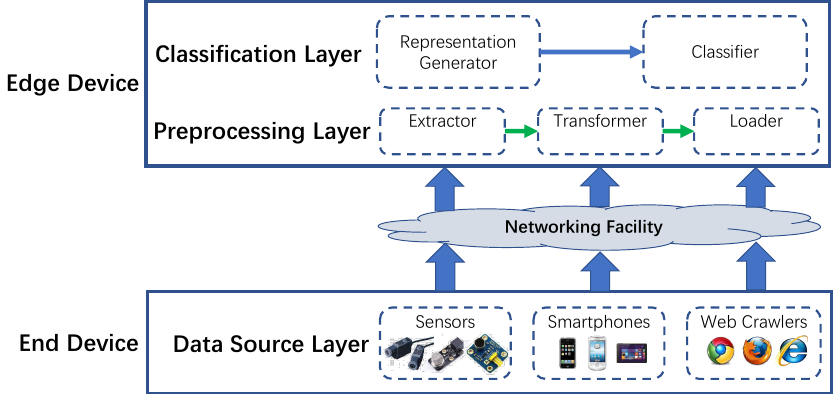
Figure 1. Overall architecture of Edge4TSC. TSC = Time Series